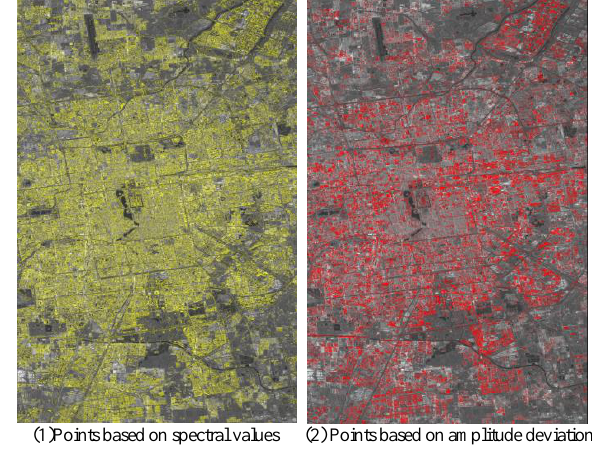
Figure 1. Image Space-time Baseline